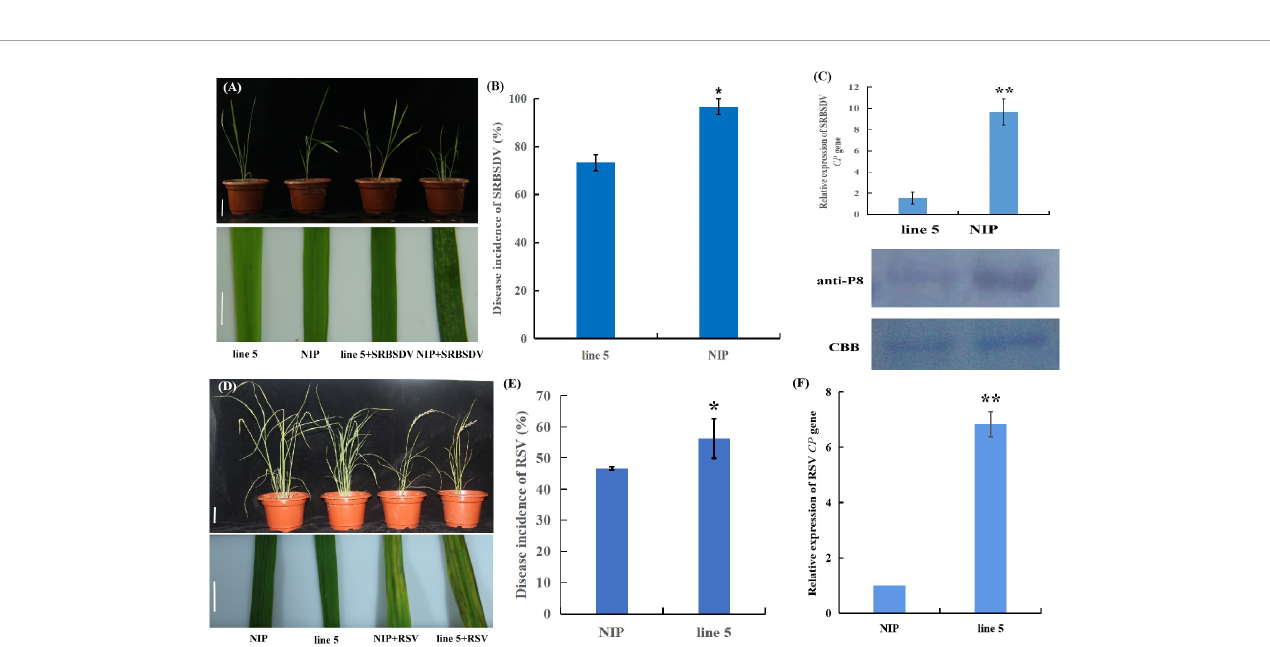
FIGURE 6 Osv-ATPase d differently modulates rice resistances to SRBSDV and RSV. (A) Representative images of mock-inoculated or southern rice black-streaked dwarf virus (SRBSDV)-infected NIP and line 5 plants. Bar = 2 cm (top). Bar = 1 cm (bottom). (B) The percentages of SRBSDV-infected NIP and line 5 plants. (C) Detection of SRBSDV levels by quantitative RT-PCR of CP gene RNA expression levels and by western blotting using antibodies against the SRBSDV P8 protein. CBB: Coomassie brilliant blue staining. (D) Representative images of mock-inoculated or rice stripe virus (RSV)-infected NIP and line 5 plants. Bar = 5 cm (top). Bar = 1 cm (bottom). (E) The percentages of RSV-infected NIP and line 5 plants. (F) Detection of RSV CP RNA expression levels by quantitative RT-PCR. * r < 0.05, ** r < 0.01 by the Student ’ s t